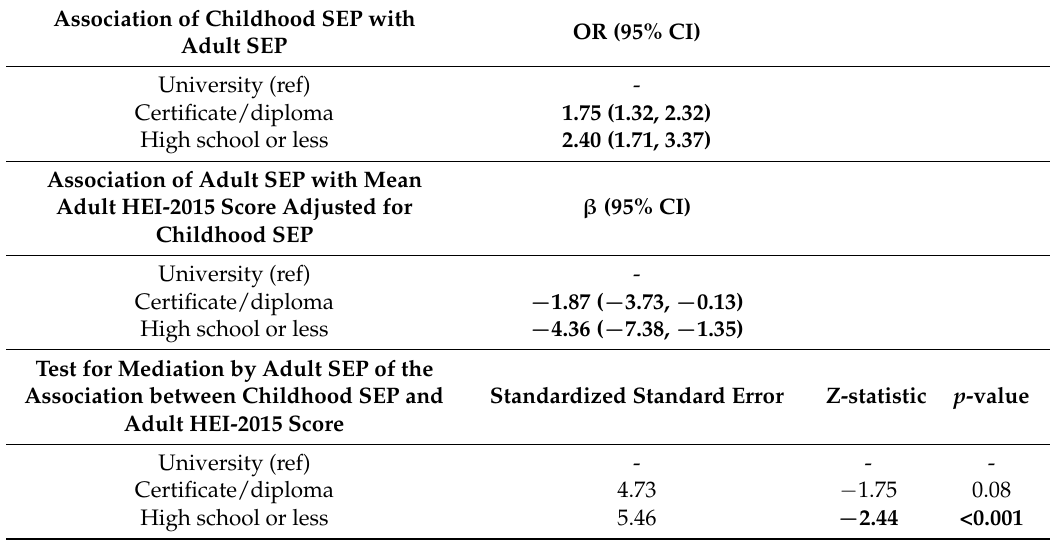
Table 4. Tests for the potential mediation of the association between childhood socioeconomic position (SEP) and mean Healthy Eating Index-2015 (HEI-2015) score in young adulthood by SEP in young